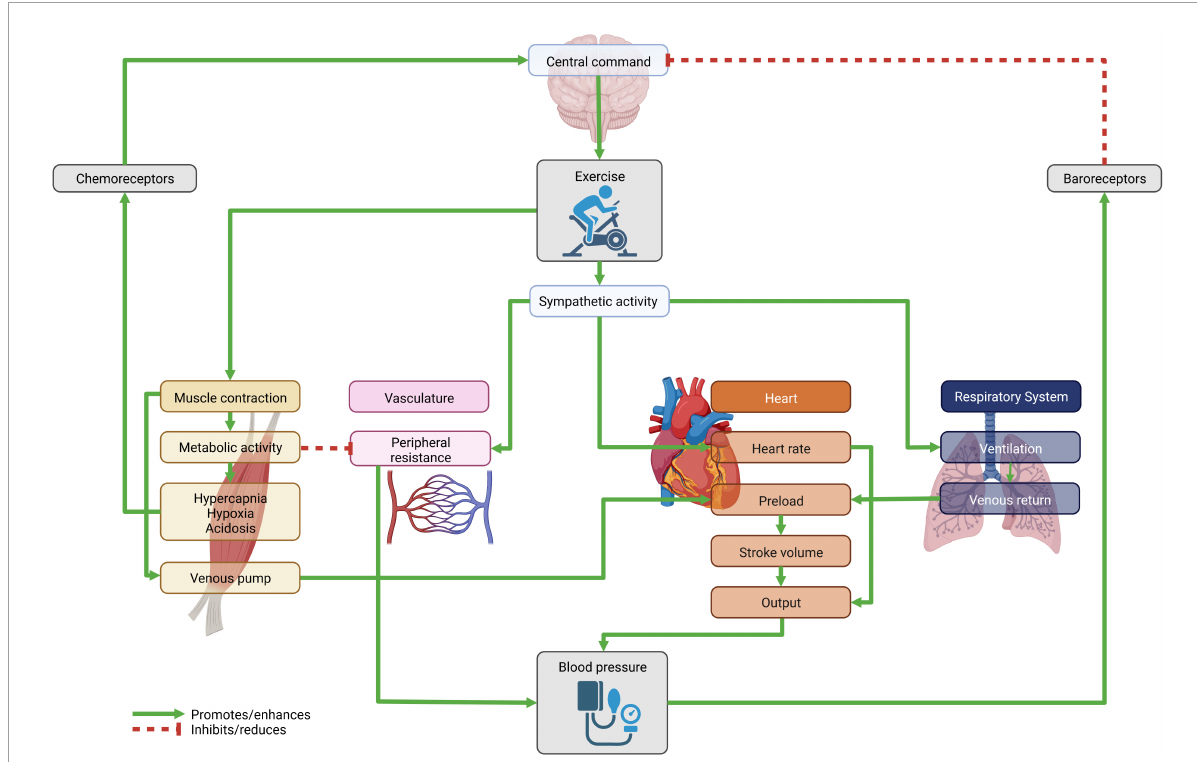
FIGURE1 Feedback loop as the physiological response to physical activity. The central command initiates muscle activity via somatomotor neurons. Simultaneously the vascular, heart and respiratory systems are activated, in part through the increasing sympathetic activity. This leads to a surge in cardiac output and peripheral vascular resistance, which in turn raises (systolic) blood pressure. The change in hemodynamics triggers the baroreceptor reflex, while the metabolic activity of muscle exertion is sensed by chemoreceptors. Figure created with